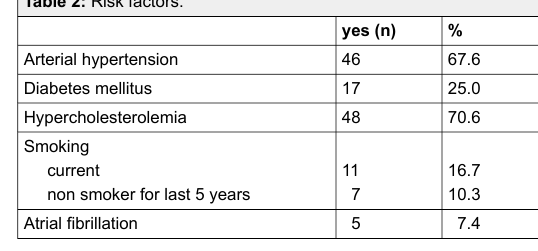
Table 1: Neuropsychological